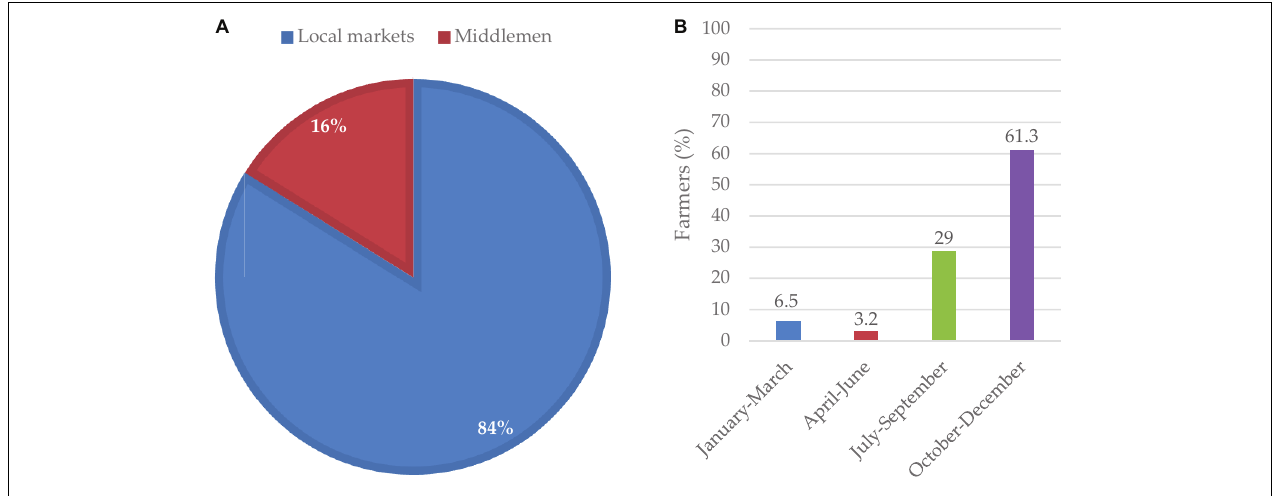
FIGURE 3 | Lablab marketing channels (A) and the peak selling period (B) .